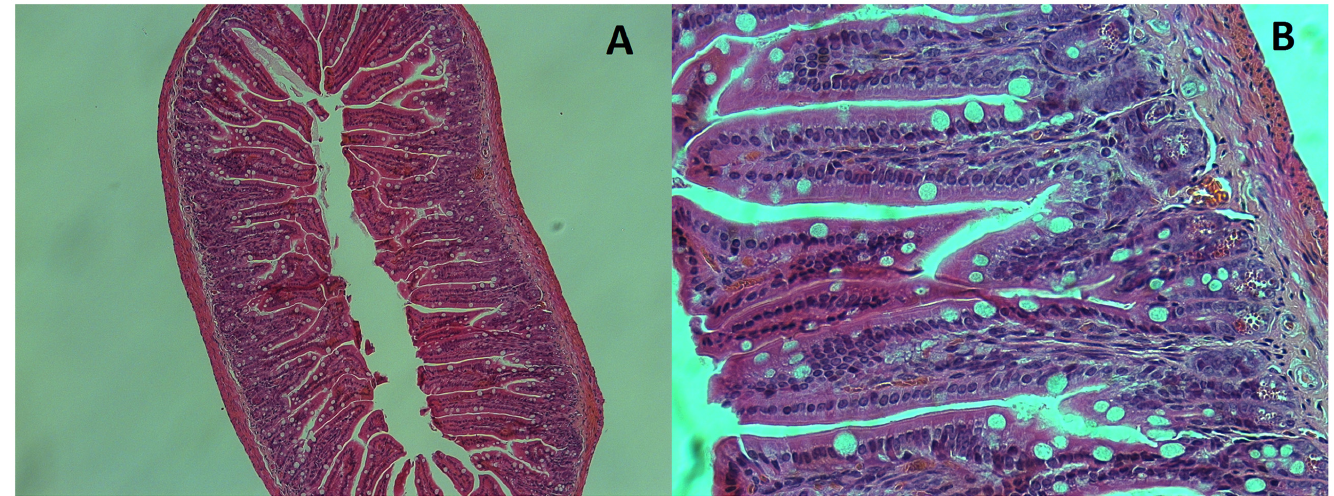
Fig 3. A, and B: Hematoxylin and eosin stain of an ileum section of a mouse 2 days after oral challenge with 10 7 CFU of E . coli strain 536. A: 10X magnification. B: 40X magnification.